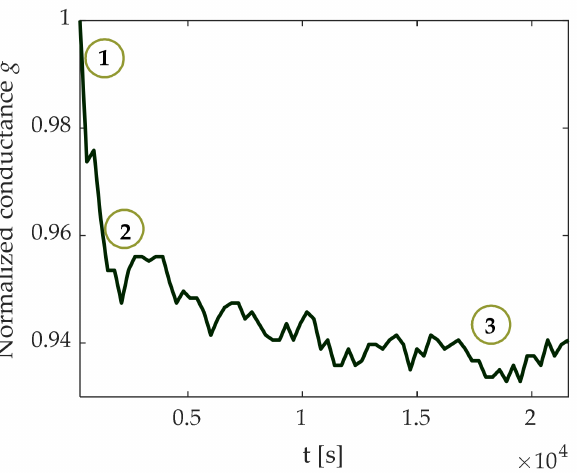
Figure 2. Measured time behavior of a cell normalized conductance showing undesired phenomena: (1) uncertainty of initial value; (2) drift; (3)